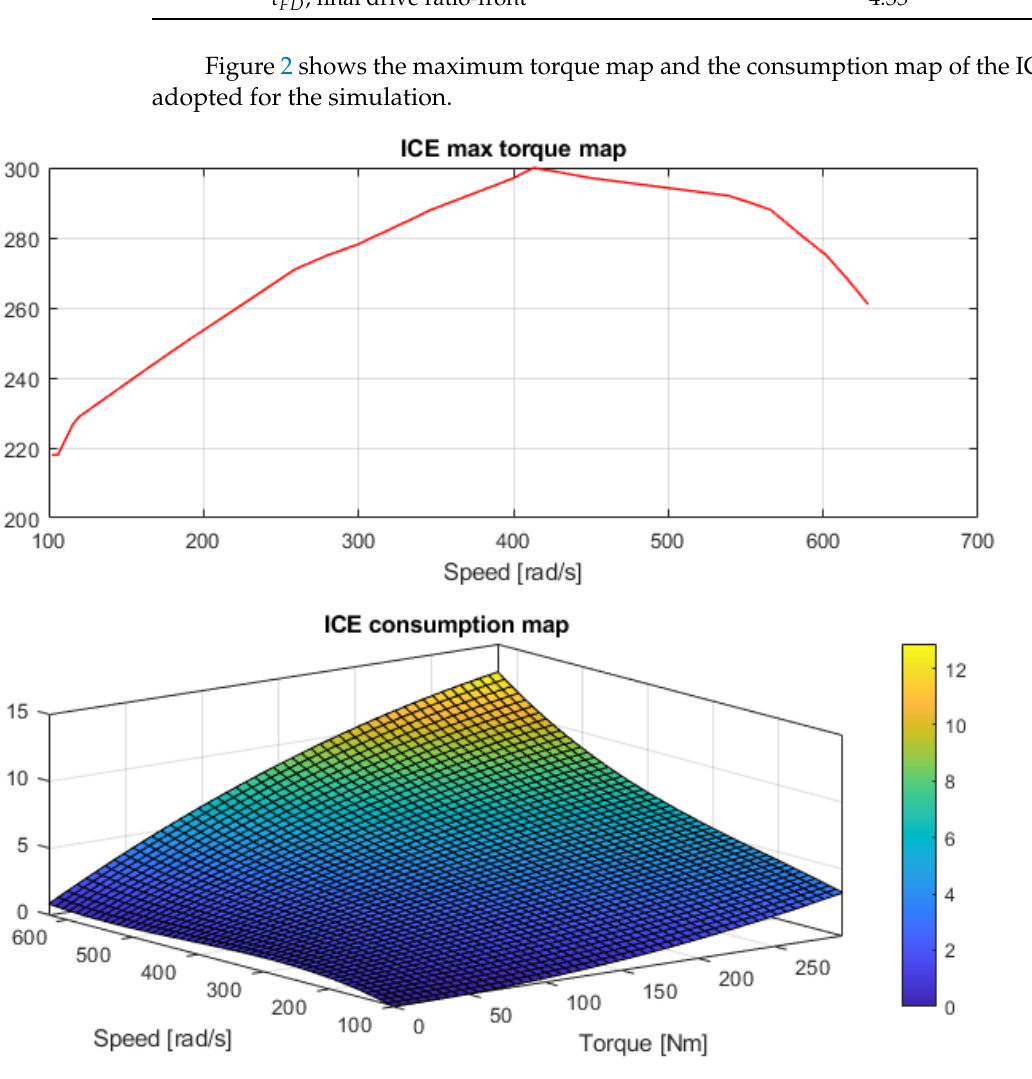
Table 1. Reference vehicle geometry and transmission main parameters.